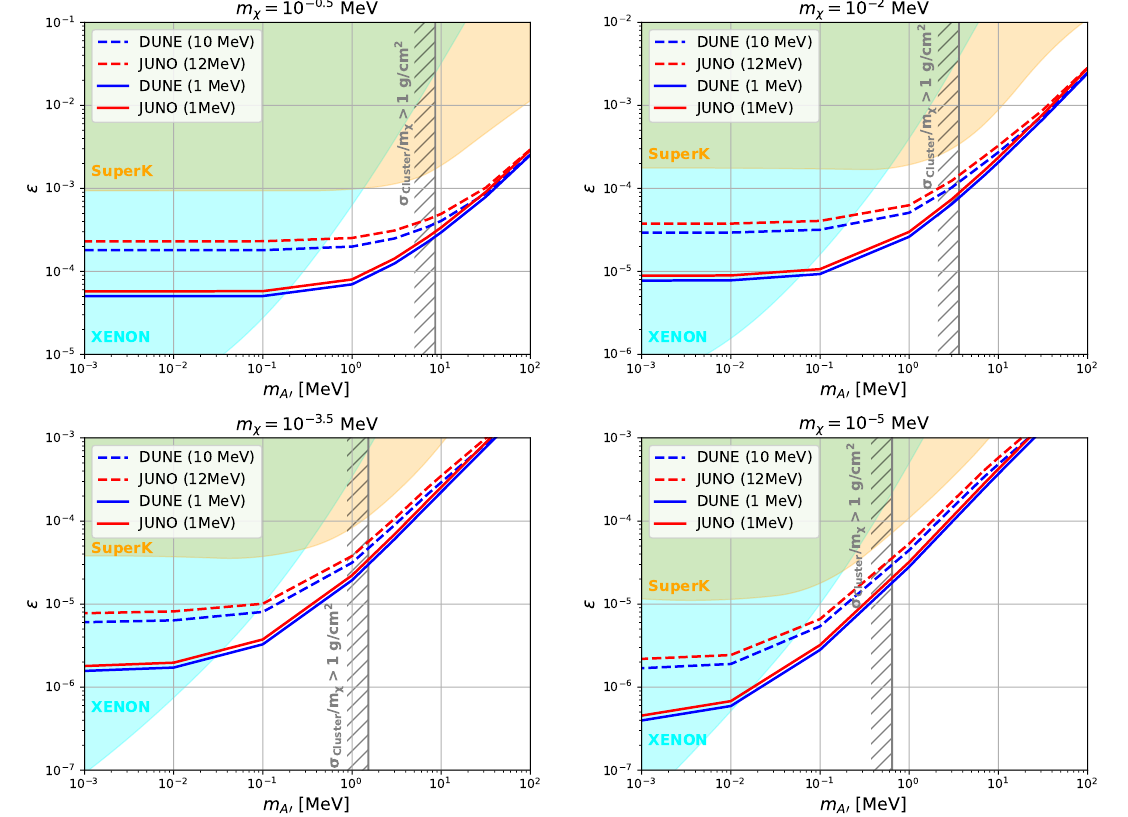
Figure 7 . The orange shaded regions and cyan shaded regions correspond to the Super-K and XENON1T bounds. The DM self-interaction constraints are shown by hatched vertical lines, and regions on the left-hand side are excluded. The blue lines and red lines correspond to the contours of three signal photon events in each year at DUNE and JUNO, respectively. The threshold of the photon detection is indicated by the line types as explained in the legend. We choose four different DM masses for demonstration, the values of which are given in the titles of